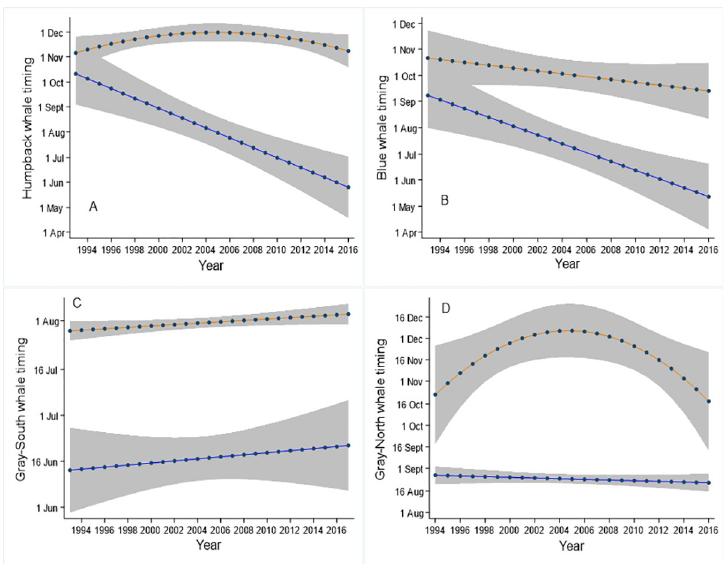
Fig 4. Interannual trends in the timing of day of arrival and departure. Shown are the arrival (blue) and departure (orange) trends for humpback (A), blue (B), gray-south (C), and gray-north (D). Blue whale departure, gray-north arrival, and gray-south arrival and departure, trends were significant (P > 0.05); in this case we depict the linear trend. The other four trends shown were significant. The 95% confidence intervals are depicted in gray shading.